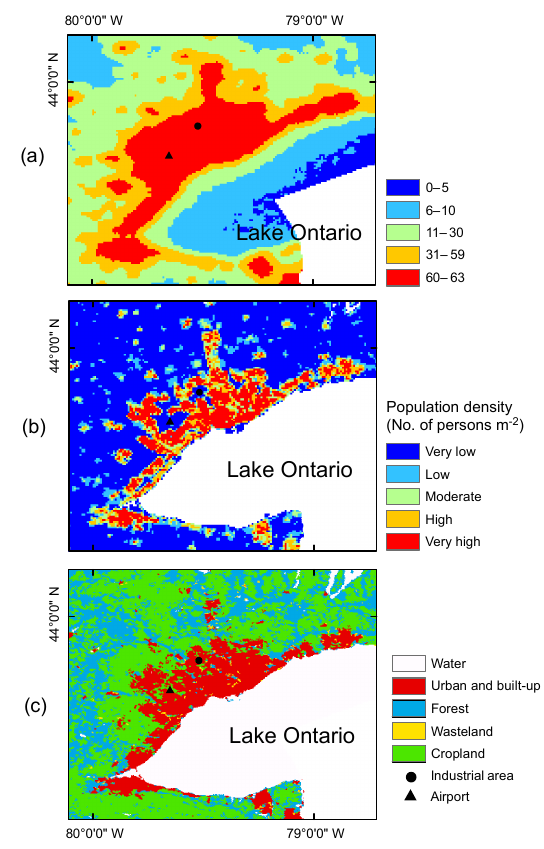
Figure 9. Comparison of population distribution and nightlights over Greater Toronto Area: (a) classified nightlights for the area with locations of the airport and a major industrial area, (b) popula- tion density over the area, and (c) land-use map of the area indicat- ing urban extent.